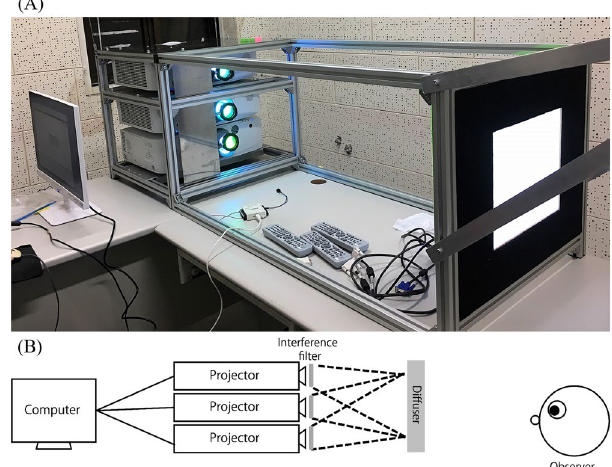
Figure 3. A set of multi-primary stimulation used in Experiment 2. ( A ) A multi-primary stimulator is a customized illumination system consisting of three projectors and interference filters which exploits a four- primary illumination system that enables independent stimulation of ipRGCs and the three types of cones. Three projectors on the left created a metameric background with different light components and projected to the screen (the light square on the right) in front of the participant, who sat at the right side that is out of the range of this photo. Black curtain covering the whole system was used in the experiment and it was removed for demonstration purpose here. ( B ) A schematic illustration of the experimental setting as described